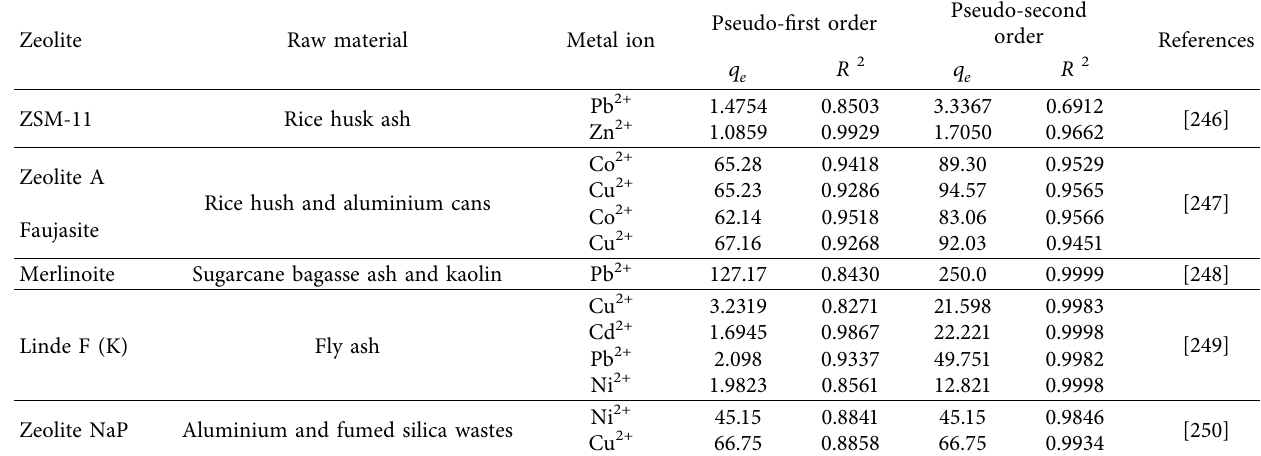
Table 10: Summary of adsorption kinetics on synthetic zeolites.